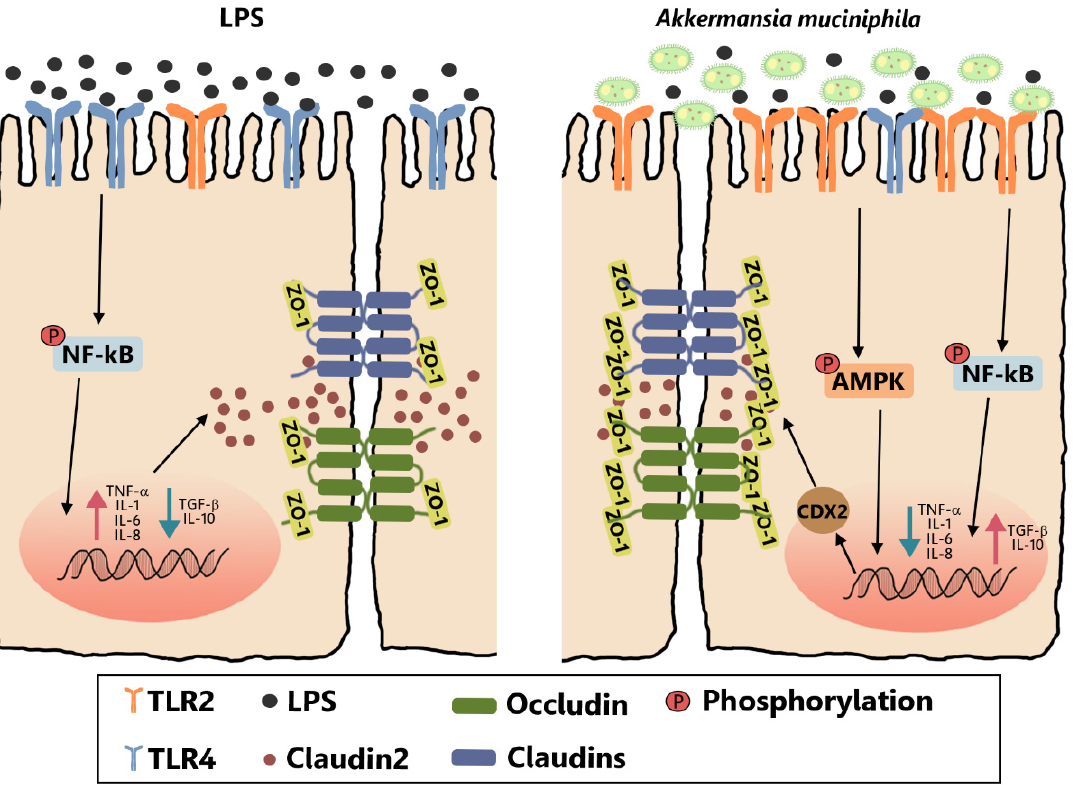
Figure 7. Pretreatment with live and pasteurized A. muciniphila can attenuate intestinal barrier dysfunction in LPS-induced Caco-2 cells by restoring the inflammatory response and by facilitating the assembly of tight junctions. The protective effects of A. muciniphila on barrier function were proved to ameliorate inflammation disorders by inhibition of the NF- κ B pathway and to increase tight junctions via CDX2 mediation by activation of the AMPK pathway, both dependent on TLR2. TLR2, Toll-like receptor 2. LPS, lipopolysaccharide. ZO, zonula occludens. CDX2, Caudal type homeobox 2. AMPK, AMP-activated protein kinase. NF- κ B, Nuclear Factor-Kappa B.